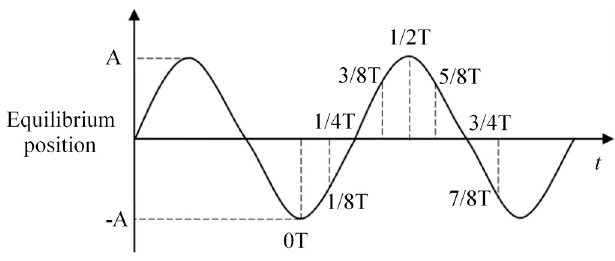
Figure 4. The relative distance between the bottom of the electrode and the workpiece in one period.